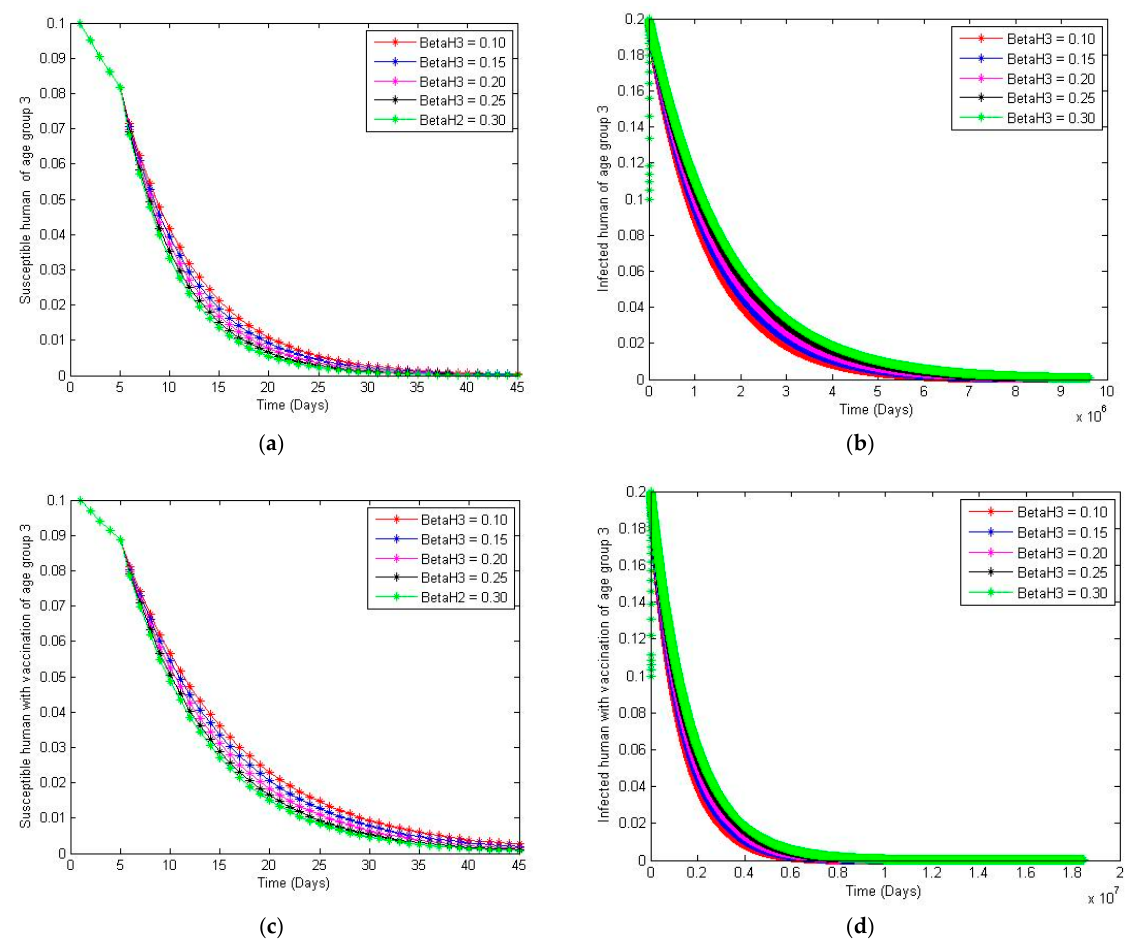
Figure 8. The trajectory of S H For R 0 > 1 ( a ) Susceptible human; ( b ) Infected human; ( c ) Susceptible human with vaccination; ( d ) Infected human with vaccination of age group